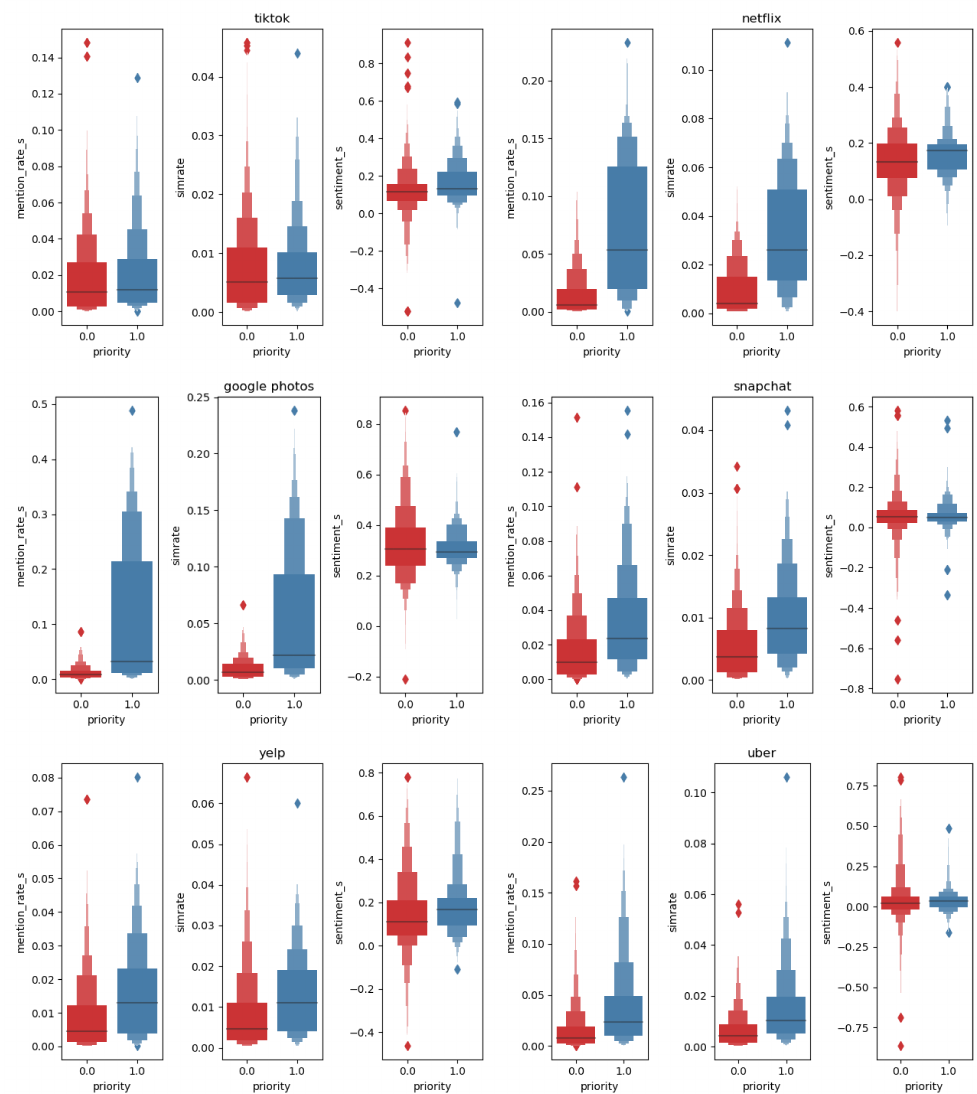
Figure 6. Enhanced boxplot for the three most important features in each app. Statistical tests were applied to analyze whether the differences of the three features between high and low priority are statistically significant. Since the number of samples is not equal, we applied the Mann–Whitney U test [50] (two-sided) and the results are listed in Table 9. At the alpha level of 0.001, mention_rate_s and simrate in high priority are significantly greater than in low priority. Except for Google Photos and Snapchat, sentiment_s in high priority is significantly greater than in low